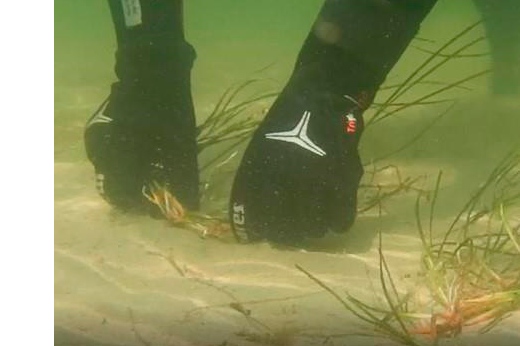
Figure 10. Panzano Bay (Gulf of Trieste) pilot transplantation by plant cuttings, inserted into the substrate by means of staples.